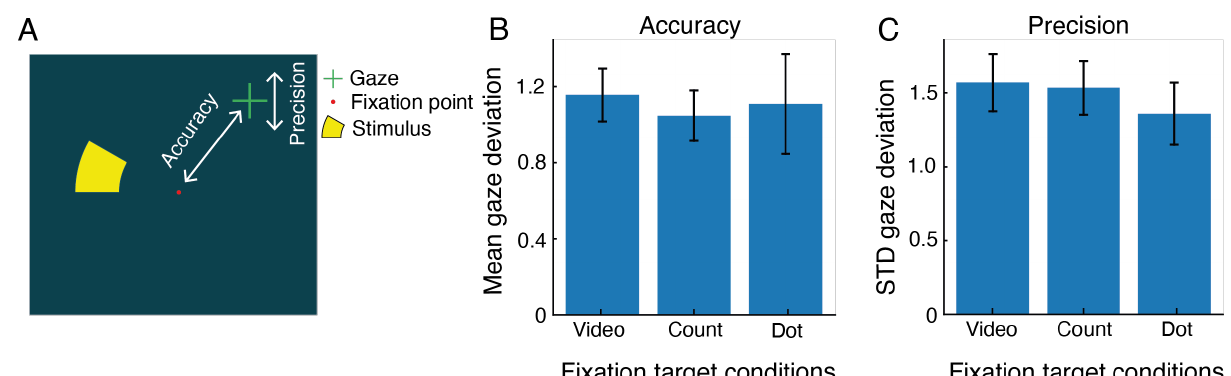
Figure 3. Gaze accuracy and precision of participants; accuracy is defined as the mean gaze deviation from fixation target and precision as the standard deviation of this gaze deviation (A). The gaze accuracy (B) and precision (C) did not significantly differ across fixation target